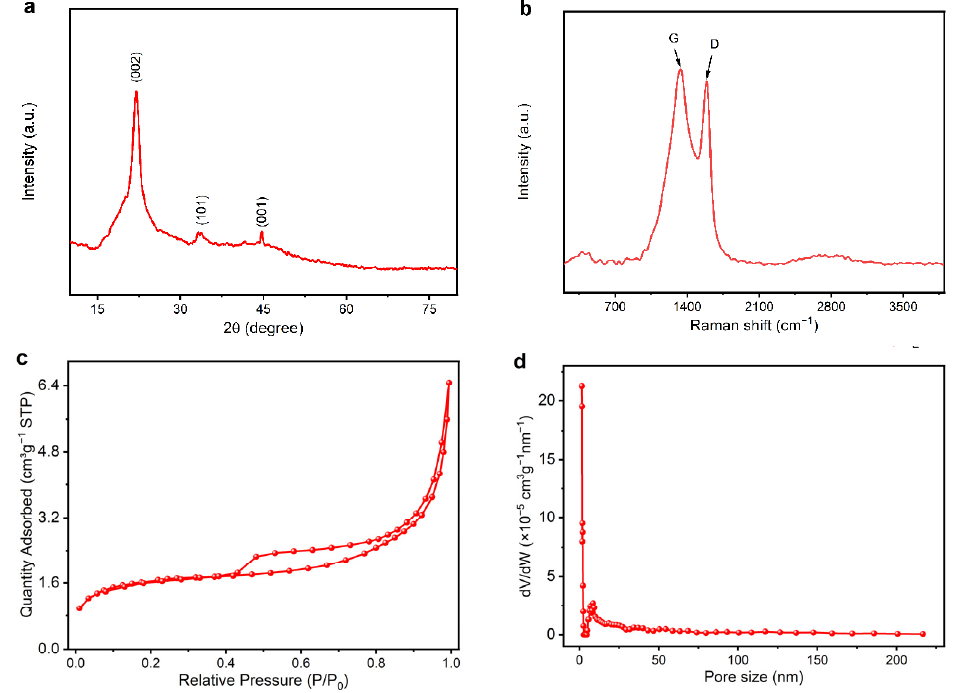
Figure 3. ( a ) XRD, ( b ) Raman, ( c ) nitrogen adsorption–desorption isotherm and ( d ) pore size distri- bution of CKF.